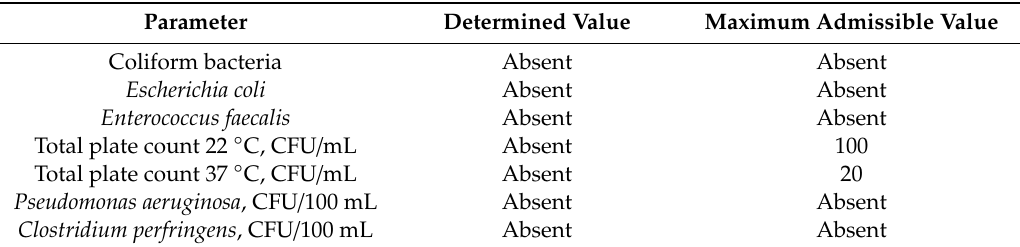
Table 9. Results of the laboratory microbiological analysis for Lucia spring water.